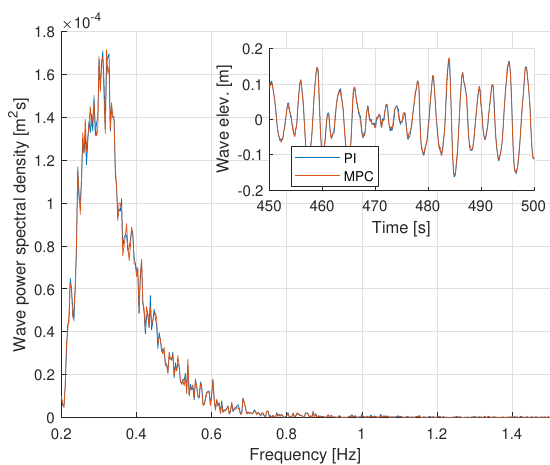
Figure 7. Wave elevation in frequency domain and in time domain (inner box) when PI controller and MPC were tested.